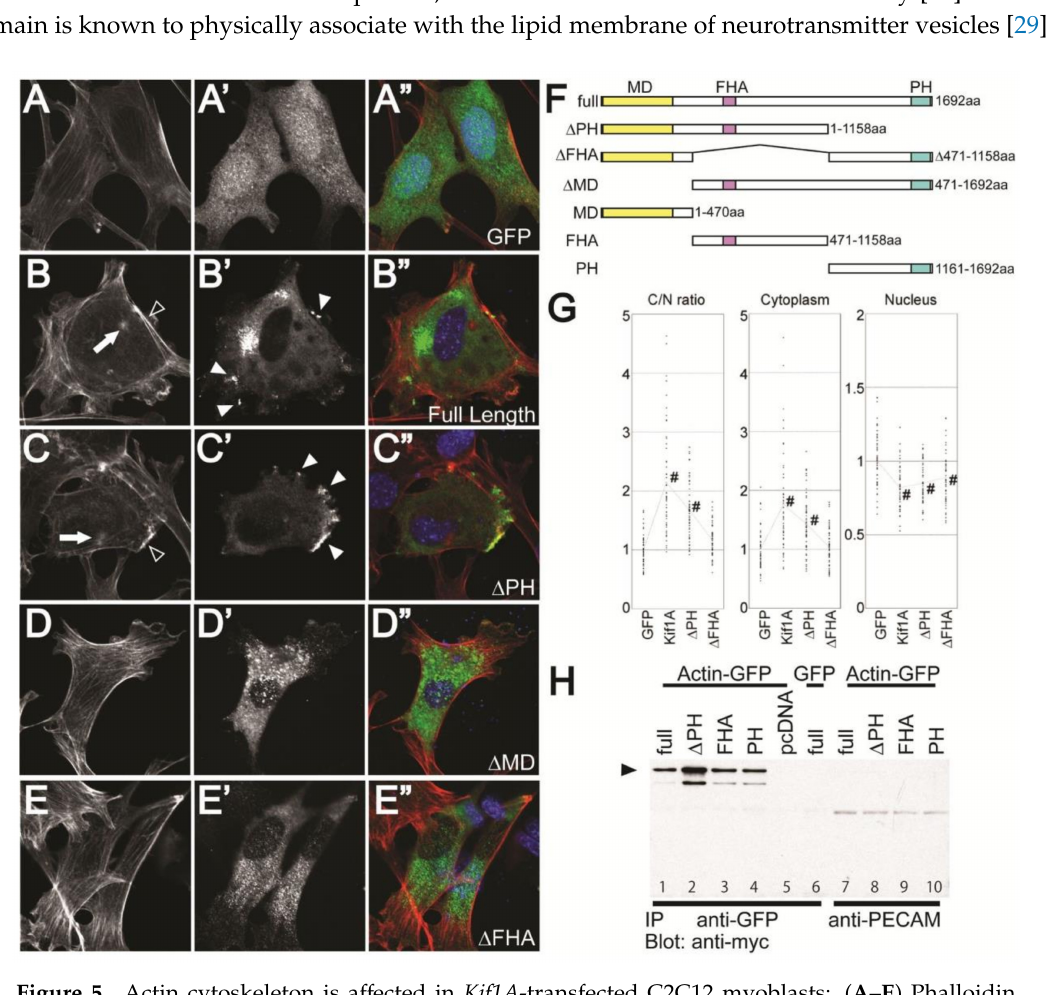
Figure 5. Actin cytoskeleton is a ff ected in Kif1A -transfected C2C12 myoblasts: ( A – E ) Phalloidin staining reveals F-actin organization in transfected C2C12 cells. α − GFP or α − myc staining identifies cells transfected with ( A’ ) AcGFP (controls), ( B’ ) full-length myc-tagged Kif1A , ( C’ ) myc-tagged Kif1A lacking the PH domain, ( D’ ) myc-tagged Kif1A lacking the MD domain, and ( E’ ) myc-tagged Kif1A lacking the FHA domain. The F-actin organization is displaced more towards the periphery of the